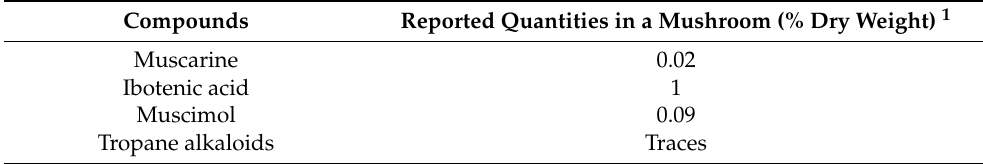
Table 1. Compounds and their relative quantities in the